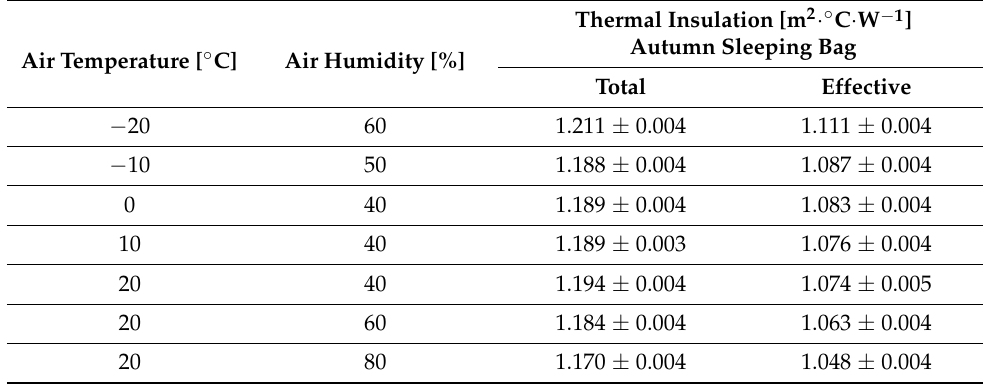
Table 8. Average thermal insulation of a mannequin in an autumn sleeping